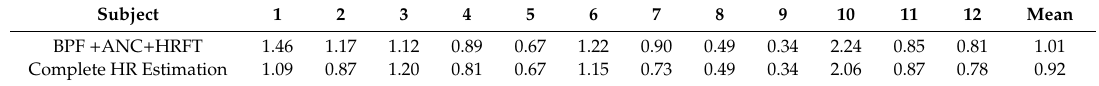
Table 3. Results of HR AAE for the complete HRF estimation algorithm.